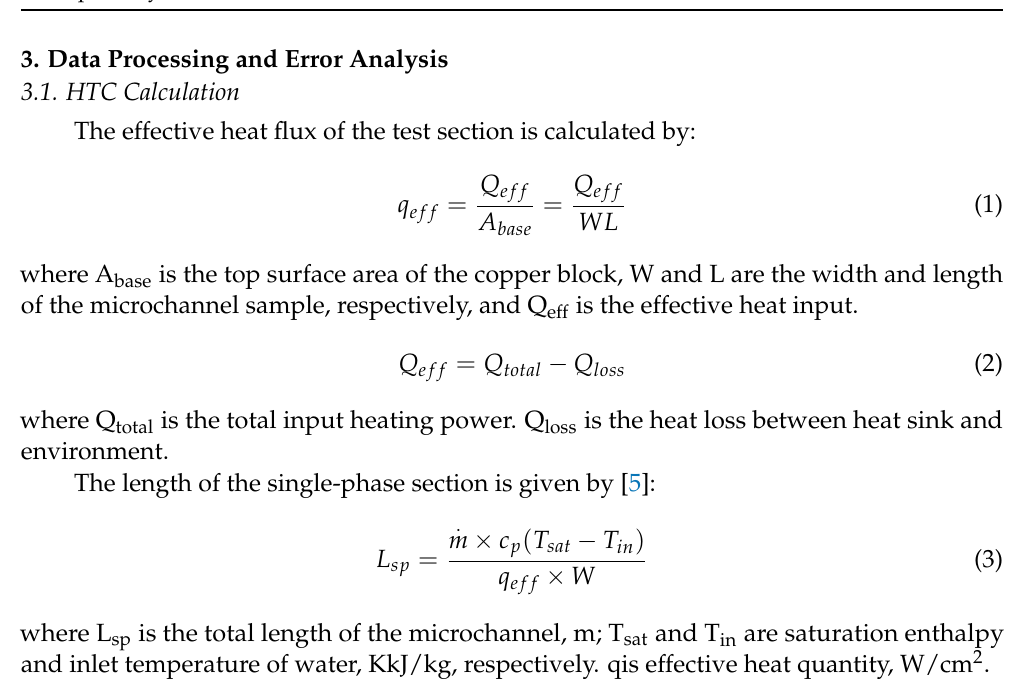
Table 3. Parameters of microchannels sintered with 30 μ m spherical copper powder.